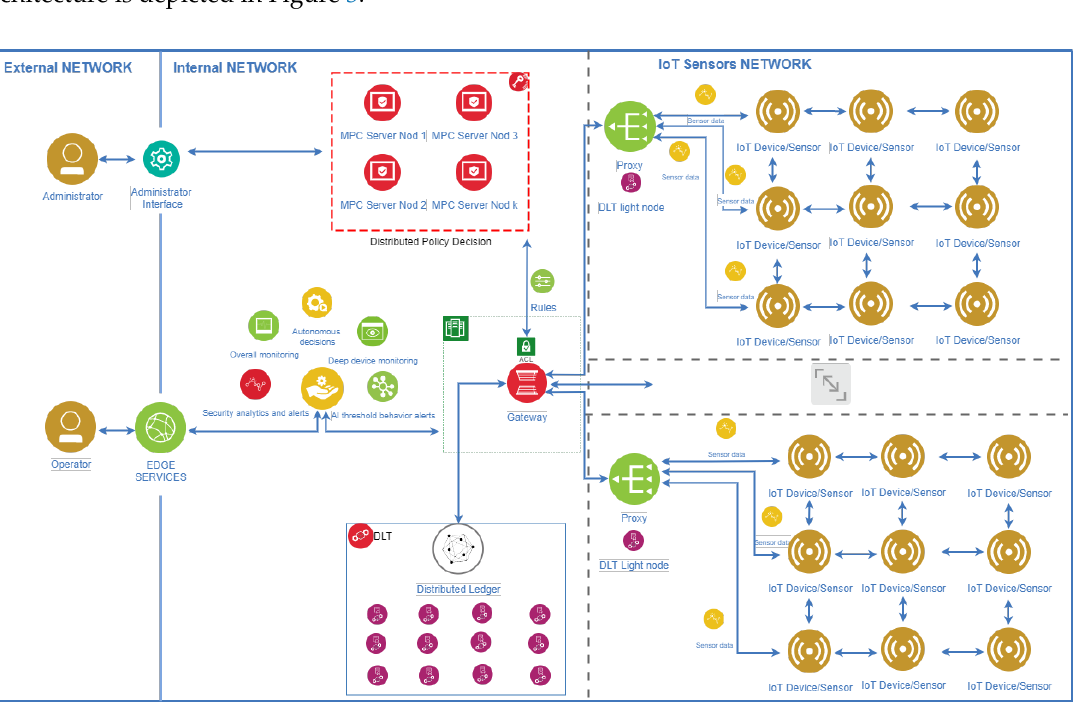
Figure 3. The authentication framework.